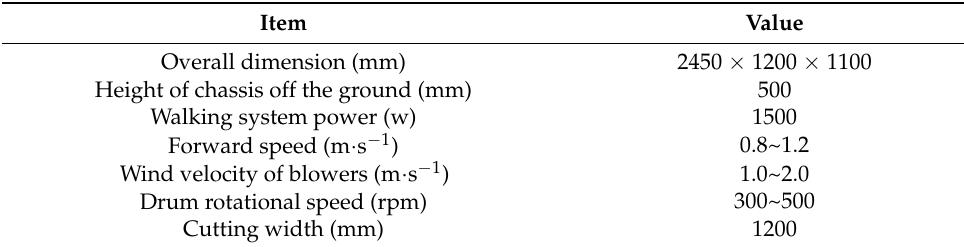
Table 1. Parameters table of dandelion seed